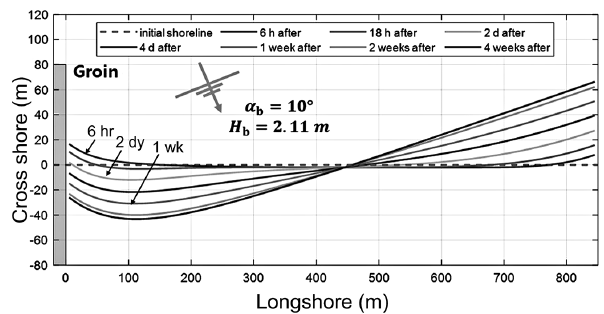
Figure 16. Results of the numerical model, showing spatial and temporal variation in the eroding beach planform for α b = 10 ◦